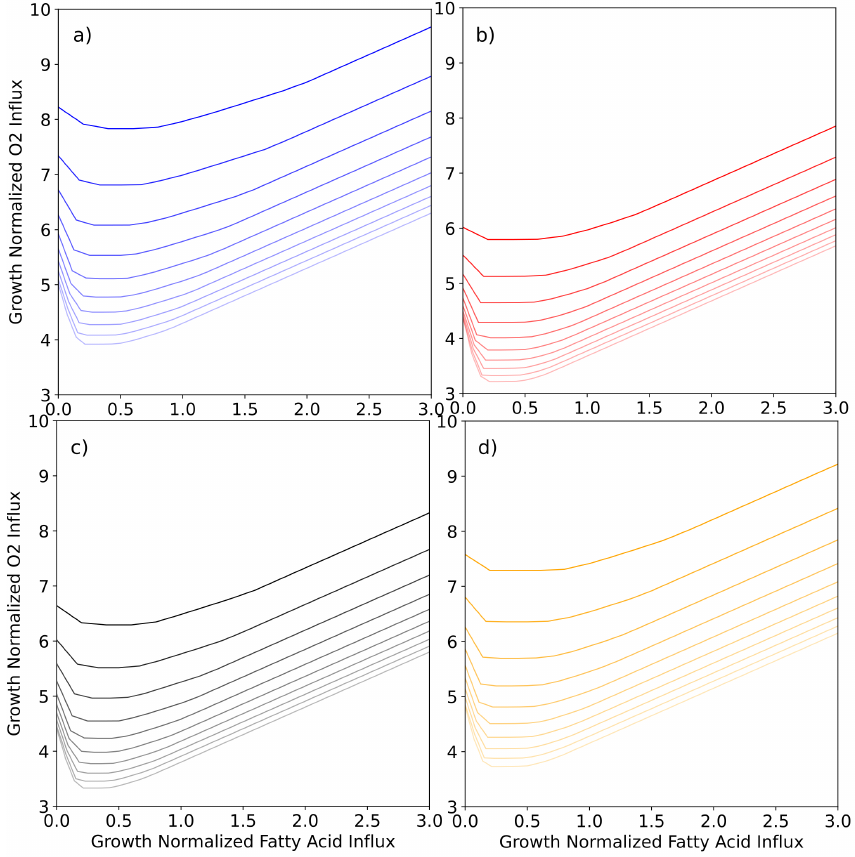
Figure 5. Simulating minimum oxygen requirement in response to various fatty acid uptake and biomass constraints. Fatty acid influx constraints were applied to each of the model instances ( a ) sensitive—blue lines, ( b ) oxaliplatin-resistant—red lines, ( c ) sensitive in DMSO-containing medium— black lines, and ( d ) BOLD-100/KP1339-resistant—yellow lines. Using a parsimonious flux variability analysis (pTFVA; see Methods and Materials for details) the minimum possible oxygen uptake was calculated for each fatty acid constraint. The calculations were performed for various growth rate constraints ranging from 5 to 15h − 1 , as indicated by the fading lines. Fatty acid influx constraints were applied as the combined influx of stearate, palmitate, oleate, linolenate, linoleate,